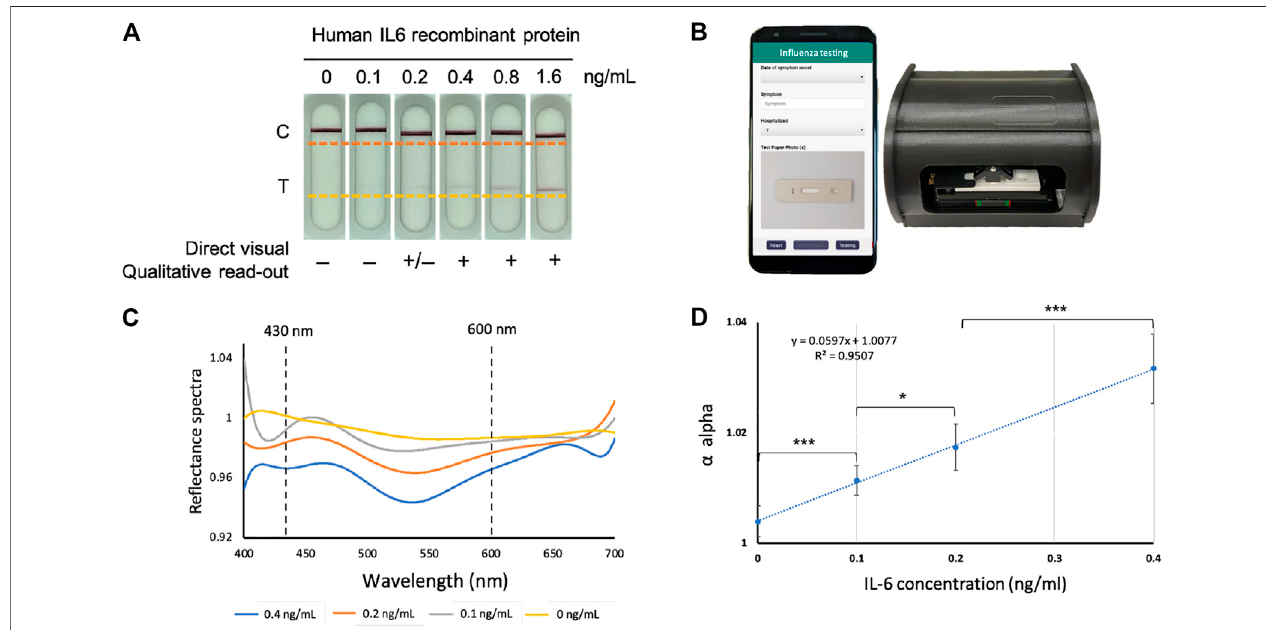
FIGURE 1 | The IL-6 paper-based test strip and spectrum-based optical reader. (A) The IL-6 test strips loaded with pre-determined amounts of puri fi ed IL-6 protein. (B) Spectrum-based optical reader and mobile-phone which could connect to the reader (in collaboration with SpectroChip Inc., Taiwan; Taiwan FDA: MD (I) - 008090and U.S.FDA:3017810861). (C) There fl ectancespectraofthepredetermined amounts ofpuri fi edIL-6protein instandard scale. (D) Linearregressionforthe α valueofIL-6protein at concentrationsof0, 0.1,0.2, 0.4 pg/mltodeterminethe limitofdetection (LOD) and limitofquanti fi cation (LOQ), Y -axis; α value, X -axis;